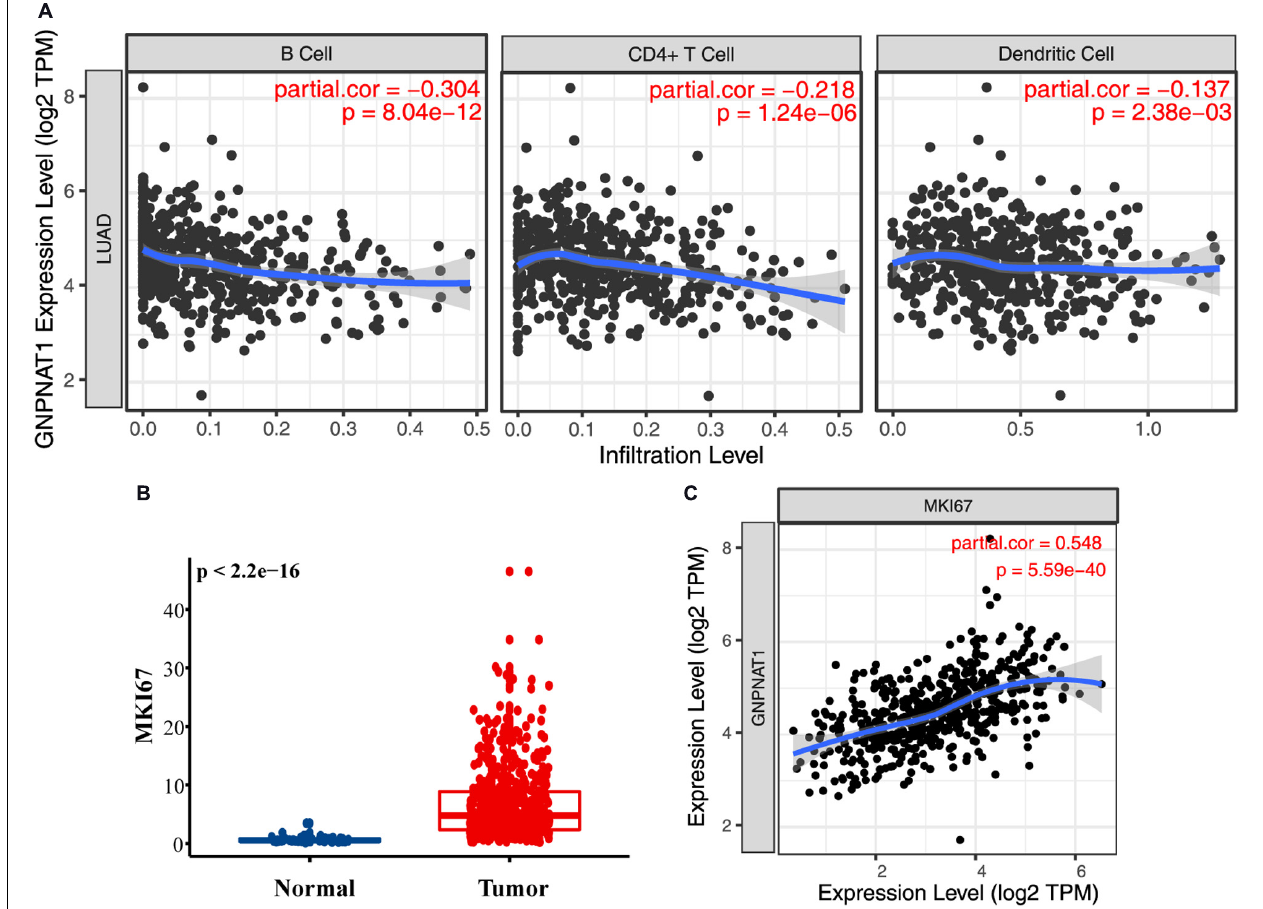
FIGURE 7 | The role of GNPNAT1 in immunomodulation for LUAD. (A) The association between GNPNAT1 expression and tumor infiltration immune cells. (B) The expression level of MKI67 in LUAD and normal tissues from TCGA. (C) The correlation of GNPNAT1 and MKI67 based on TIMER